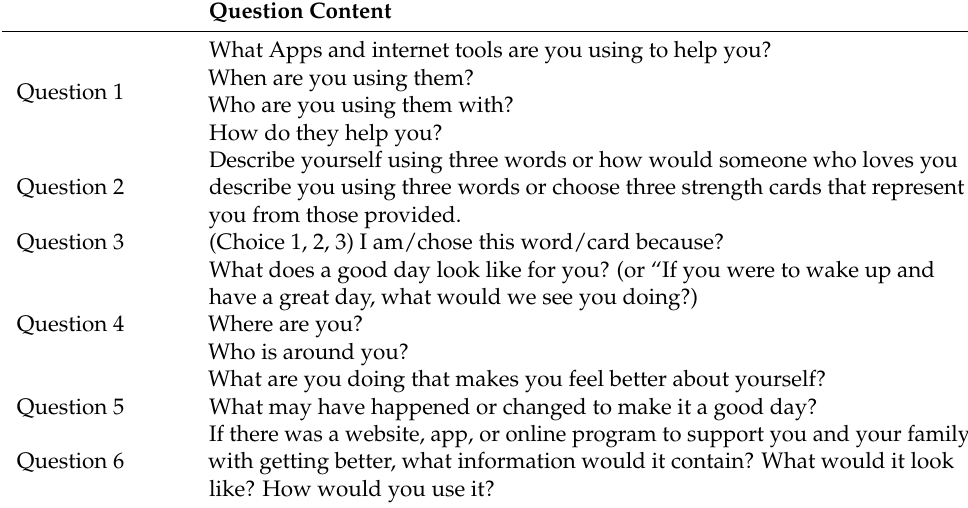
Table A1. Interview questions round 1.